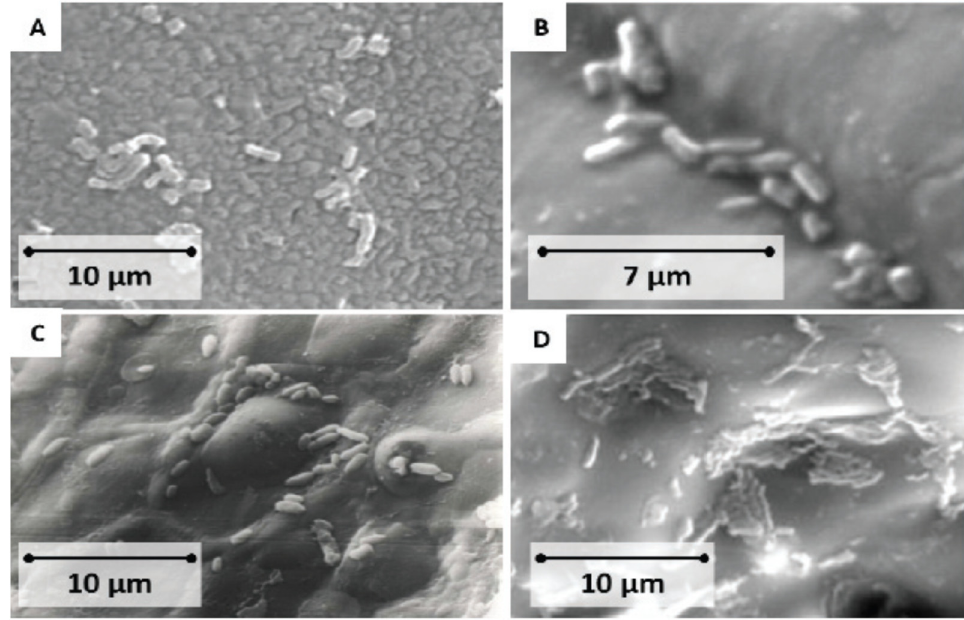
Figure 14. Subsequent stages of colonization of NCSs by Lactobacilli. ( A ) Carbonized rice husk, initial adsorption; ( B ) carbonized grape stones, initial adsorption; ( C , D ) carbonized grape stones and micro-colony formation (respectively). Reprinted with permission from Ref. [50]. Copyright